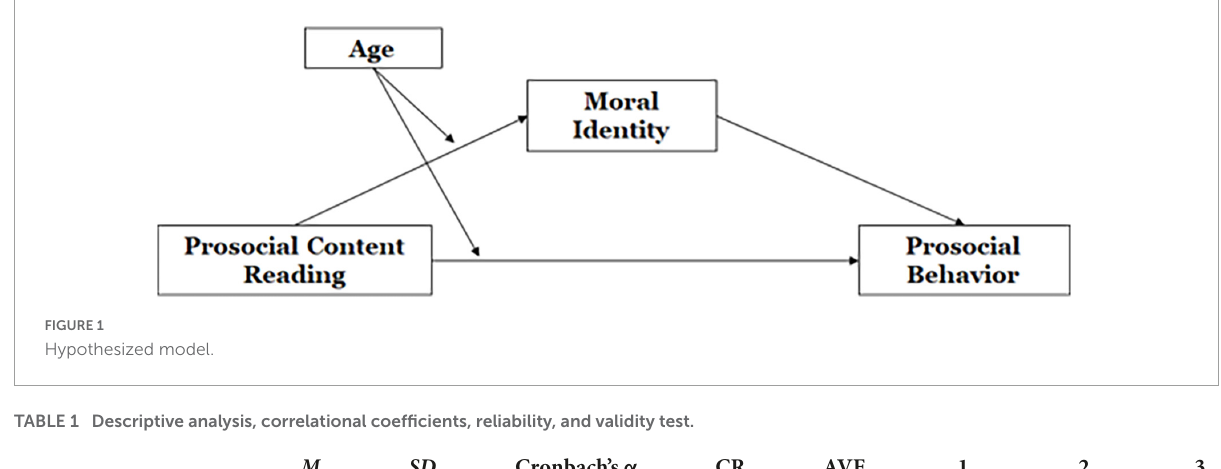
TABLE 1 Descriptive analysis, correlational coefficients, reliability, and validity